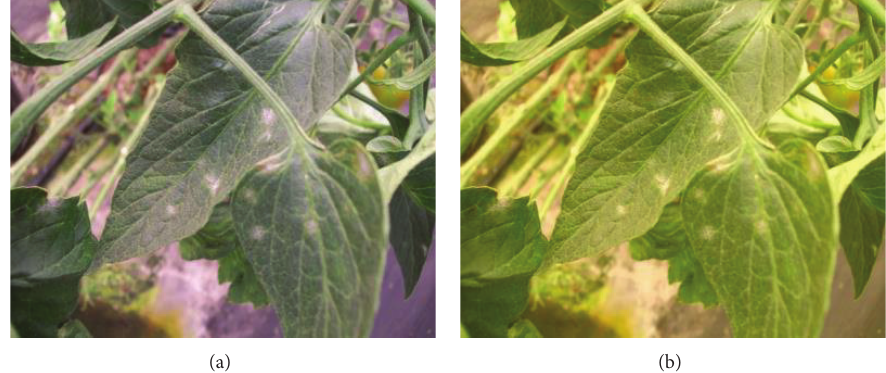
Figure 2: Image enhancement. (a) Original image and (b) image with color and brightness